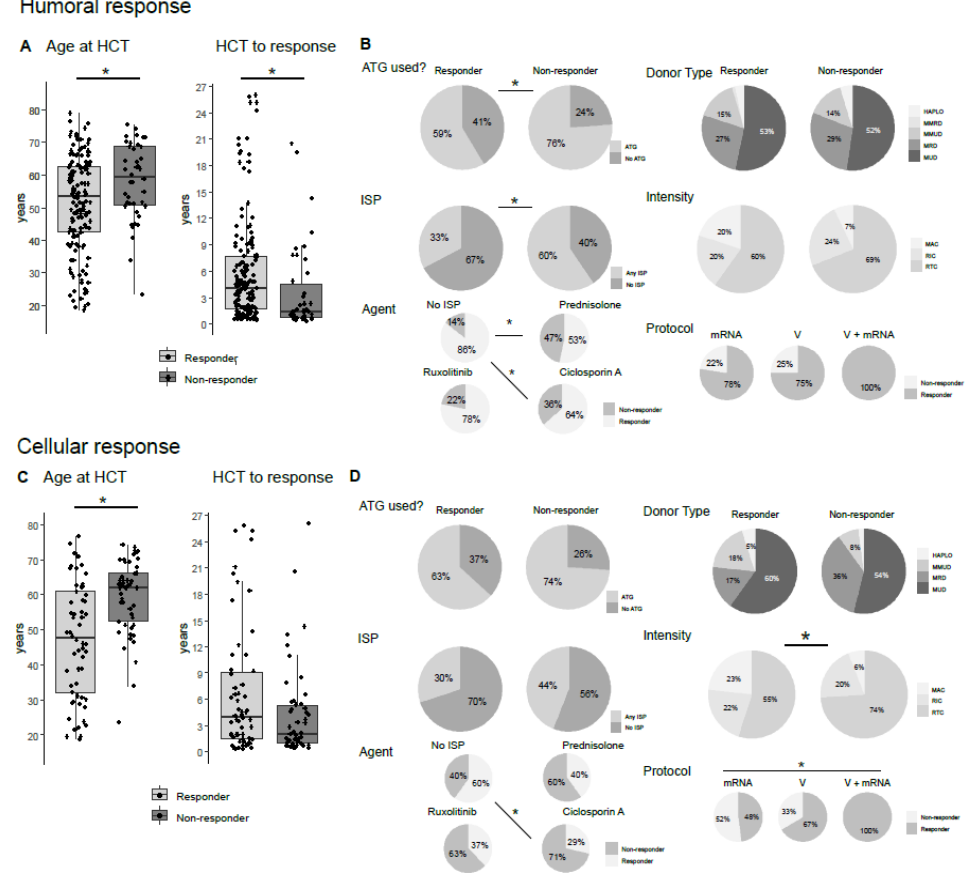
Figure 1. Humoral and cellular SARS-CoV-2 vaccination response. ( A ) Box plots display age at allo- HCT and the time from allo-HCT to best measured humoral ( A ) and cellular response ( C ) stratified according to responders and nonresponders. Points represent individual patients. ( B , D ) In the left column, pie charts show frequencies of usage of antithymocyte globulin (ATG), active ongoing treatment with immunosuppressants (ISP) and the usage of specific immunosuppressive agents in responders versus nonresponders. The right column displays frequencies of donor type, intensity of the conditioning chemotherapy and the vaccination protocol used in responders and nonresponders. Matched unrelated donors (MUD), matched related donors (MRD), mismatched unrelated donors (MMUD), mismatched related donors (MMRD), HLA-haploidentical donors (HAPLO), myeloablative conditioning (MAC), reduced toxicity myeloablative conditioning (RTC) and reduced intensity conditioning (RIC). Vaccination protocols displayed are based on only messenger RNA (mRNA) vaccines, only viral vector vaccines (V) or a heterologous combination of one-time viral vector vaccine followed by an mRNA vaccine (V + mRNA). *, p < 0.05.